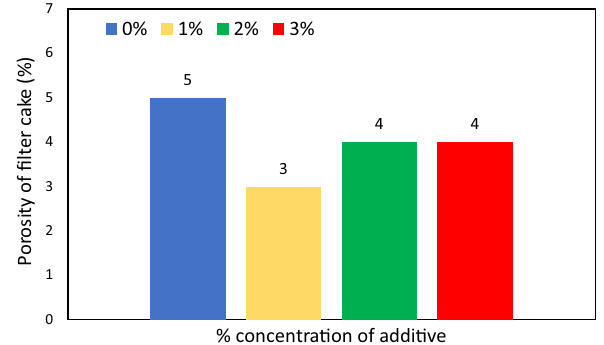
Fig. 11 Porosity of filter cake as a function of additive concentration